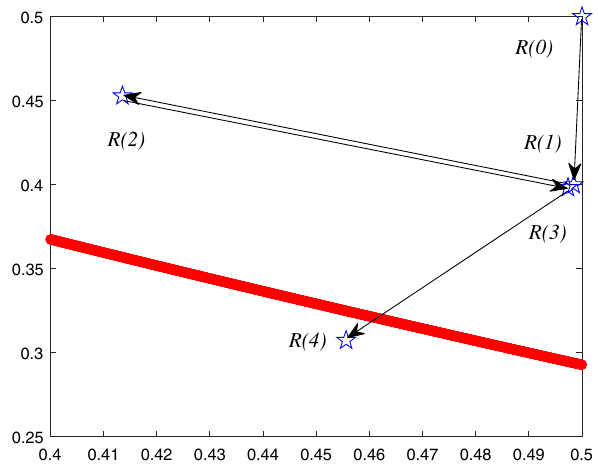
Fig. 5 The dynamic reference point in the